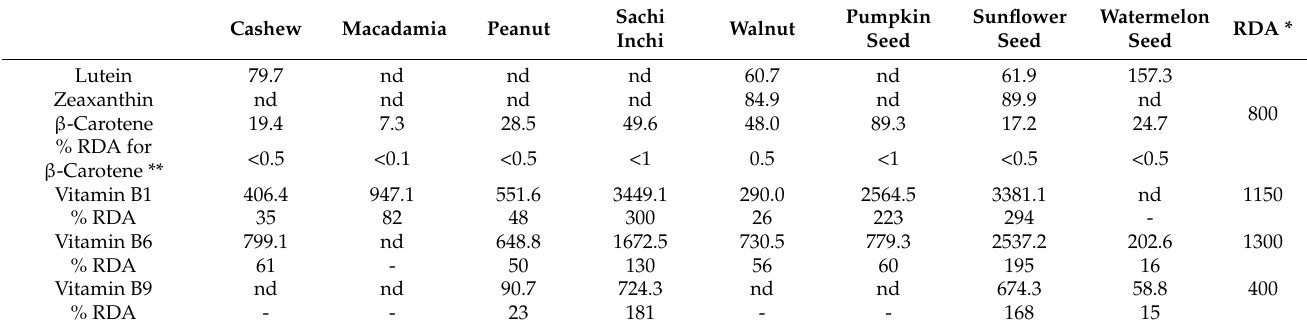
Table 2. Carotenoids and B-vitamins ( µ g/100 g FW) of the studied nuts and